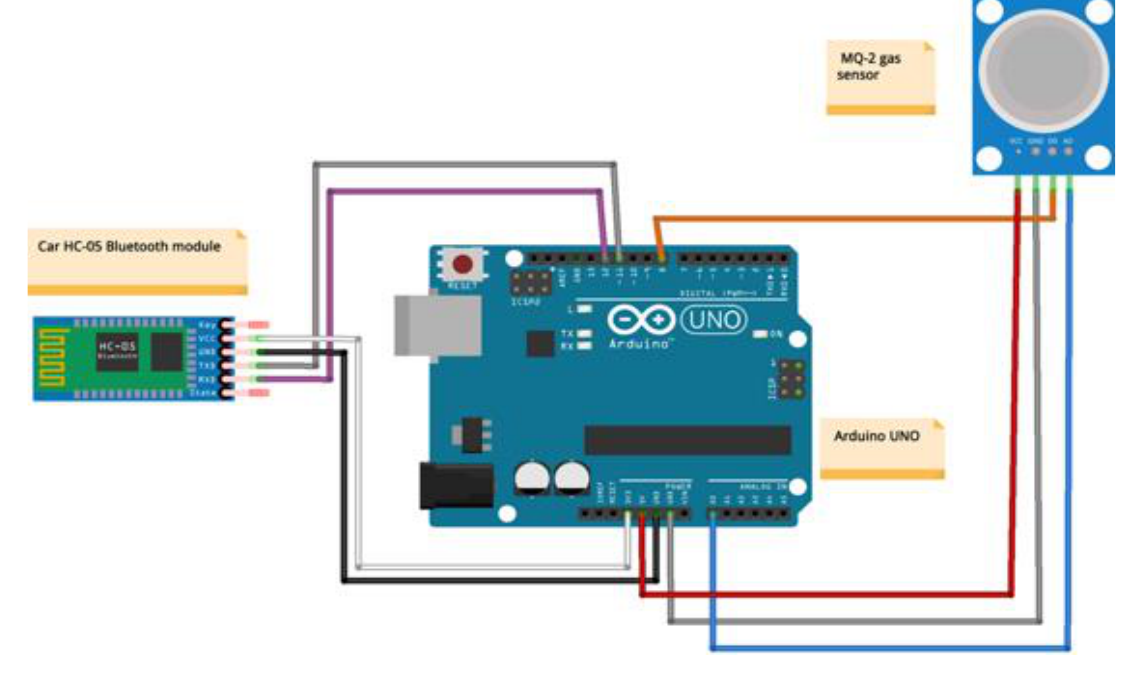
Figure 7. The tele-robot/mobile unit/car wiring schema. Table 4. The Car PIN Schema.